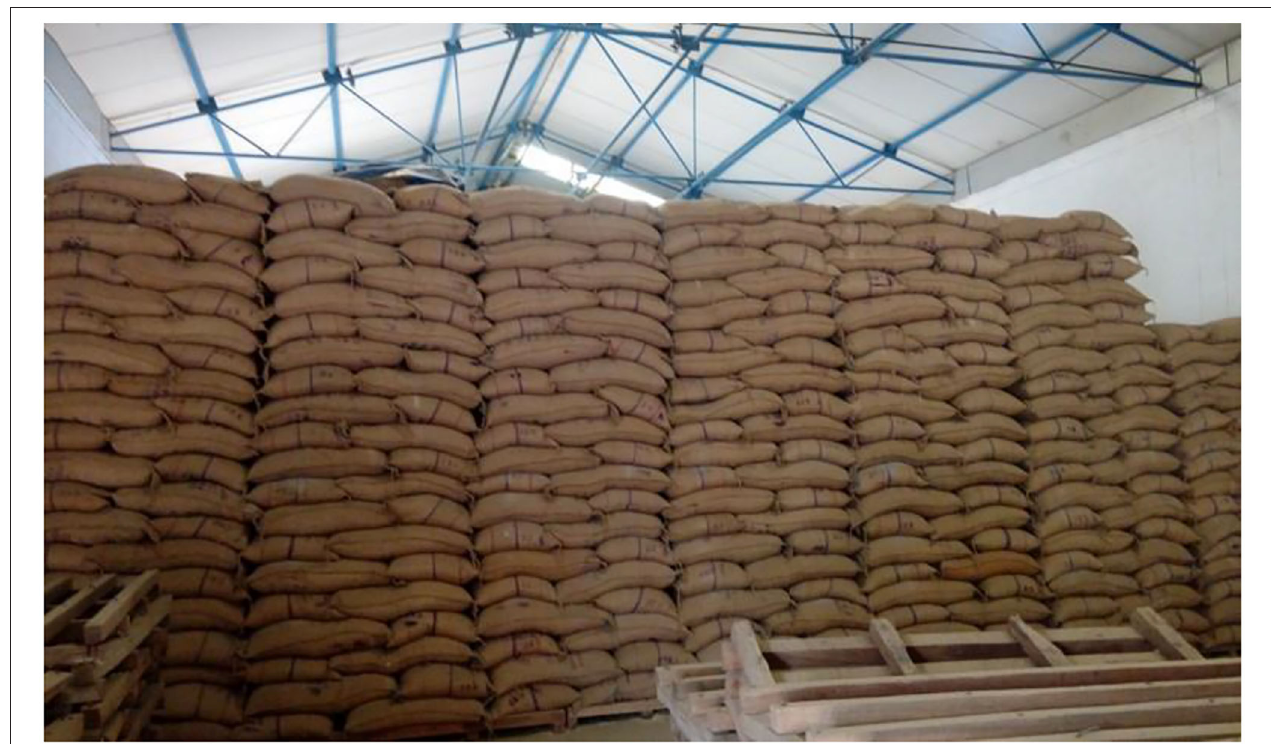
FIGURE 5 | A view of bag storage in a